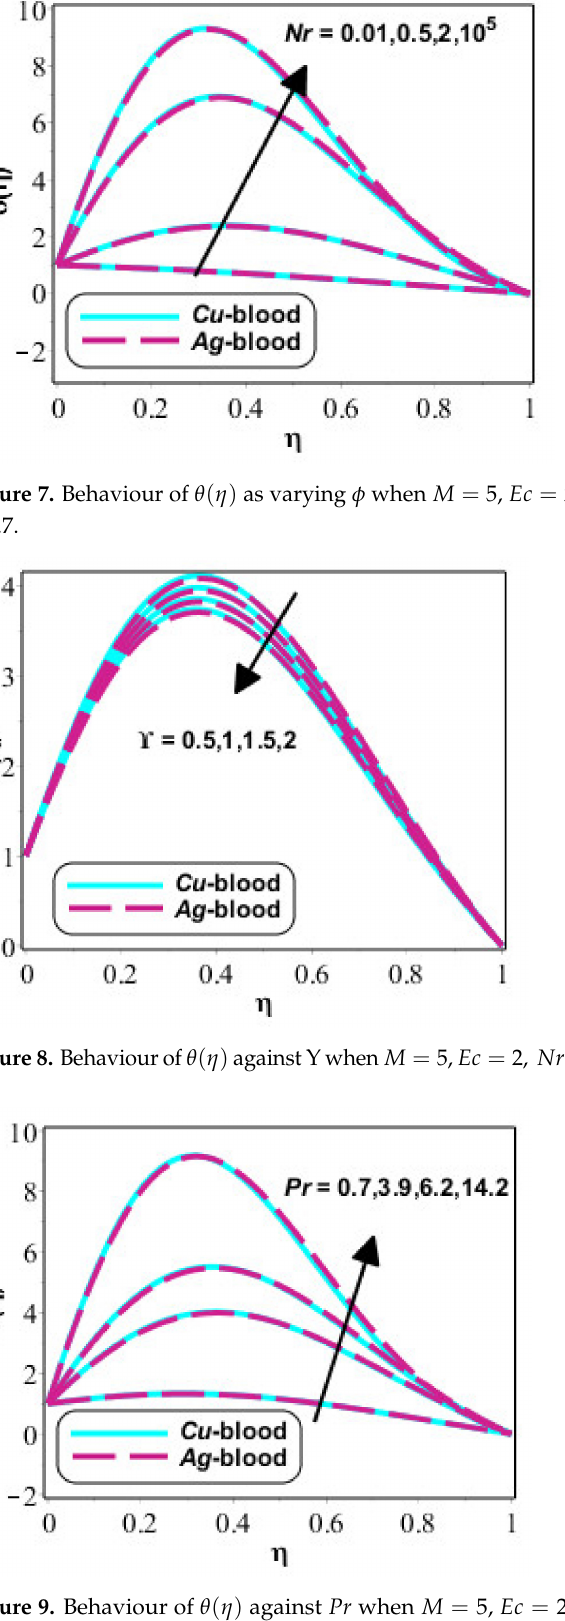
Figure 9. Behaviour of θ ( η ) against Pr when M = 5, Ec = 2, Nr = 0.5, φ = 0.1, Y = 0.8, β i = β e = 0.7